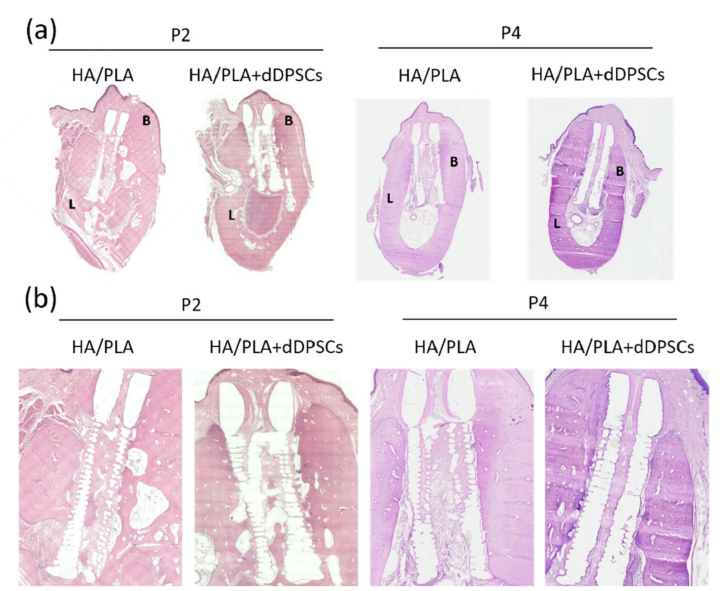
Figure 7. Photographs of the buccal-lingual histologic section of second and fourth premolar at 40 weeks. The ( a ) Mesiodistal section view. ( b ) Magnification. B: Buccal side; L: lingual side. Scale bar: 1